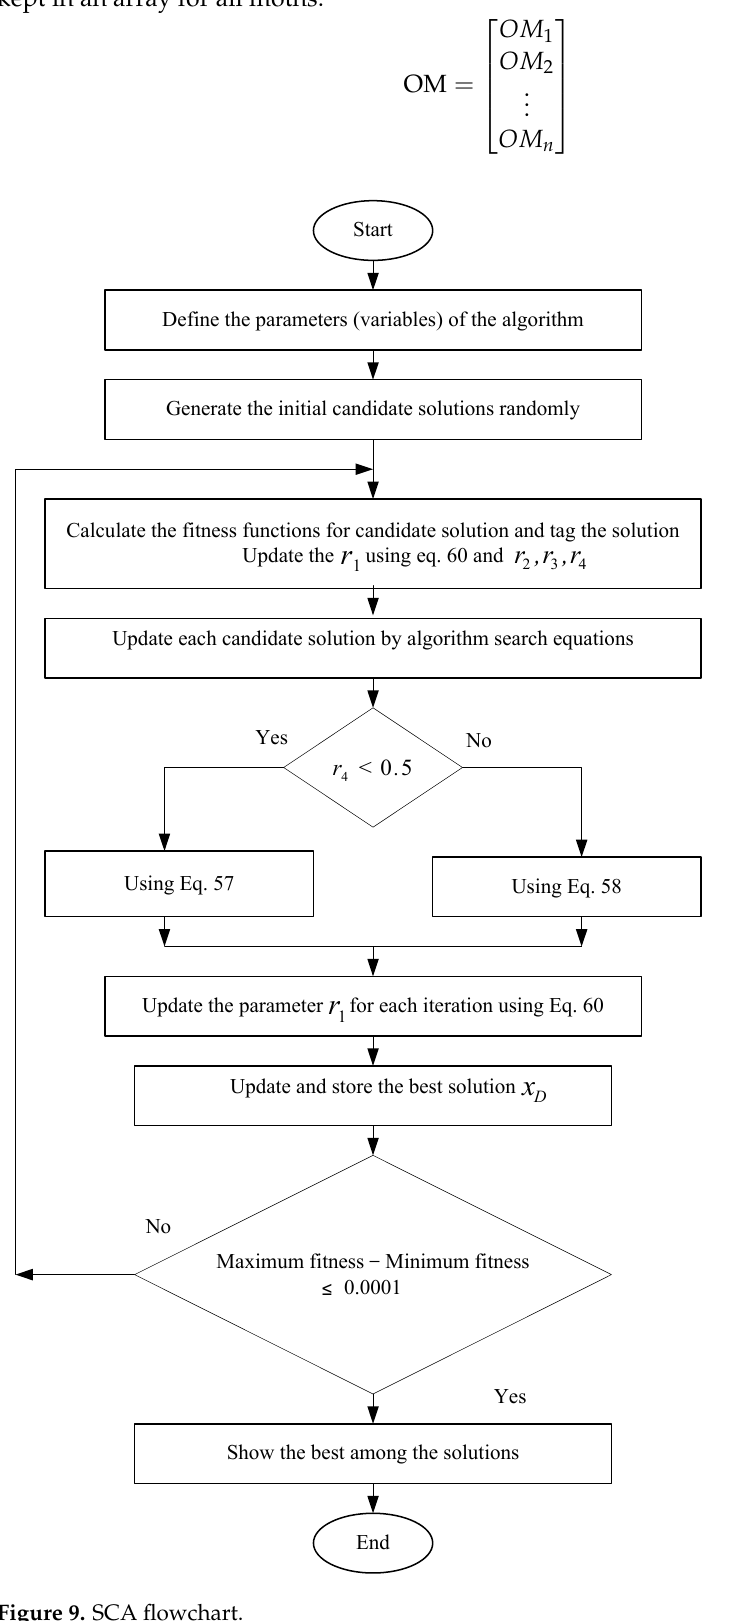
Figure 9. SCA Figure 9. SCA flowchart.